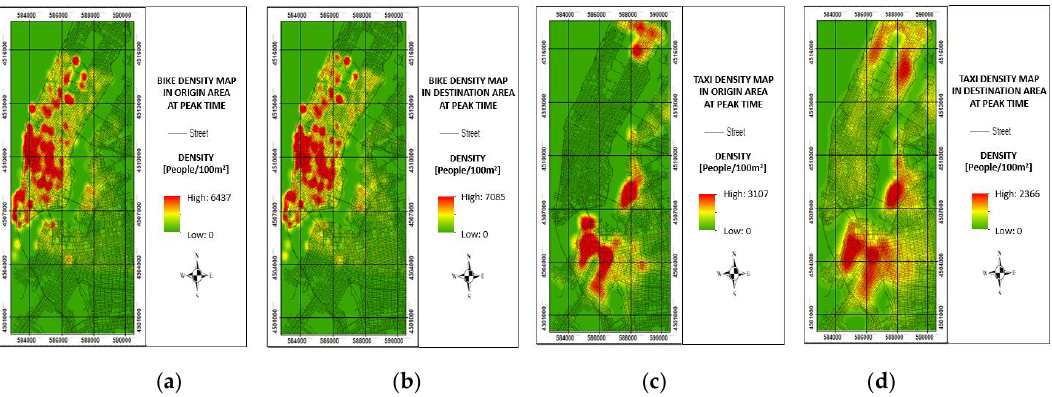
Figure 8. Bike and taxi density maps during weekend peak times: ( a ) bike origin density map at 17:00 – 18:00; ( b ) bike destination density map at 17:00 – 18:00; ( c ) taxi origin density map at 18:00 – 19:00; ( d ) taxi destination density map at 18:00 – 19:00.